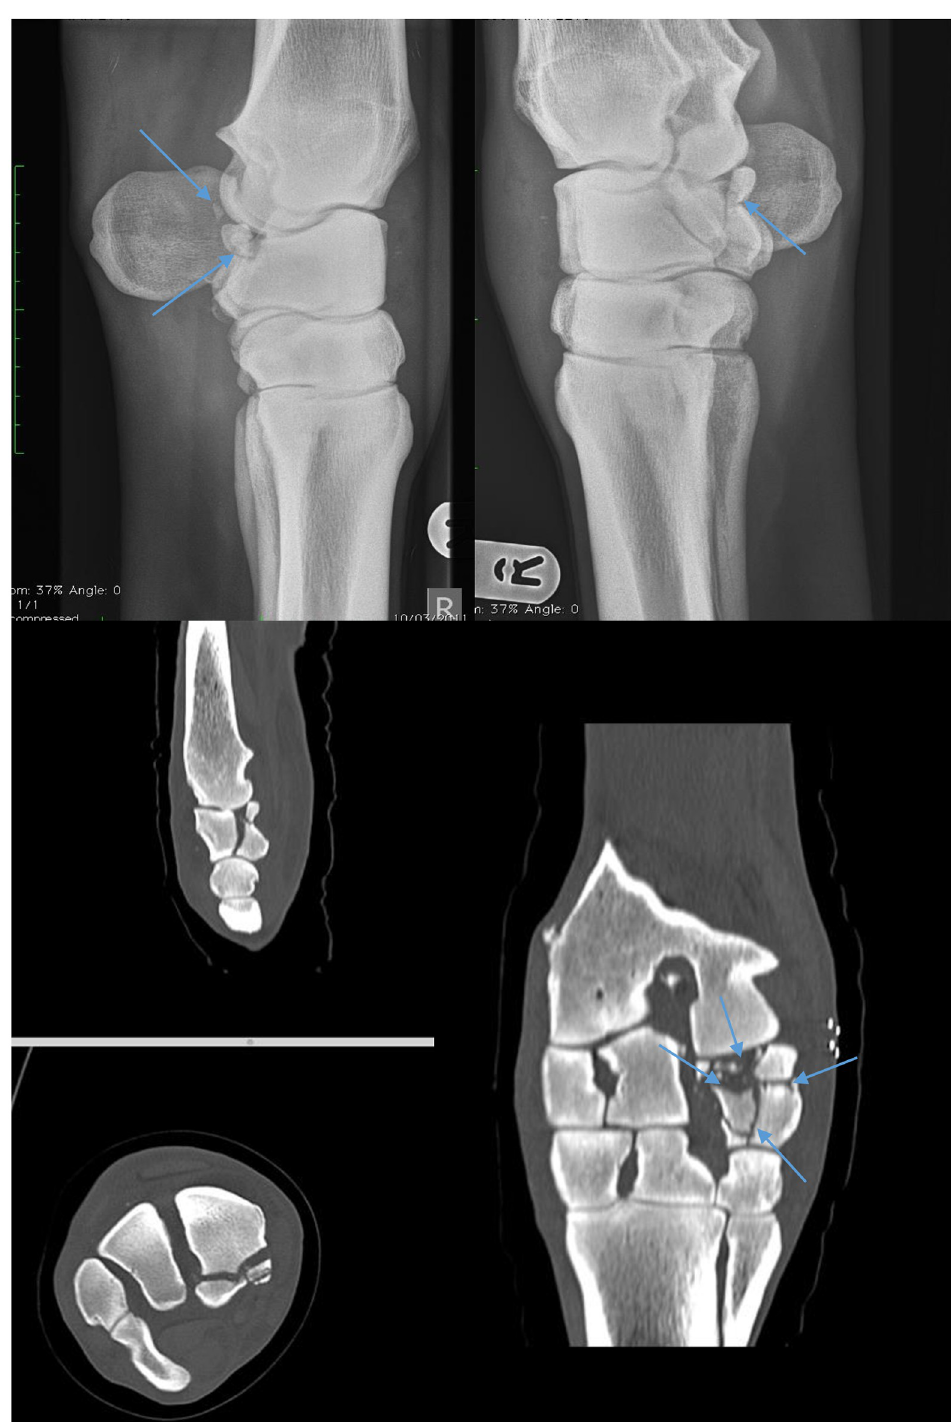
Fig 4. These are images of a carpal fracture where CT is of major significance. Following radiography the surgical plan had involved arthroscopic fragment removal, however following the CT diagnosis of severe comminution and partial joint collapse, the only viable surgical option was carpal arthrodesis. The severe comminution is labelled on this image.